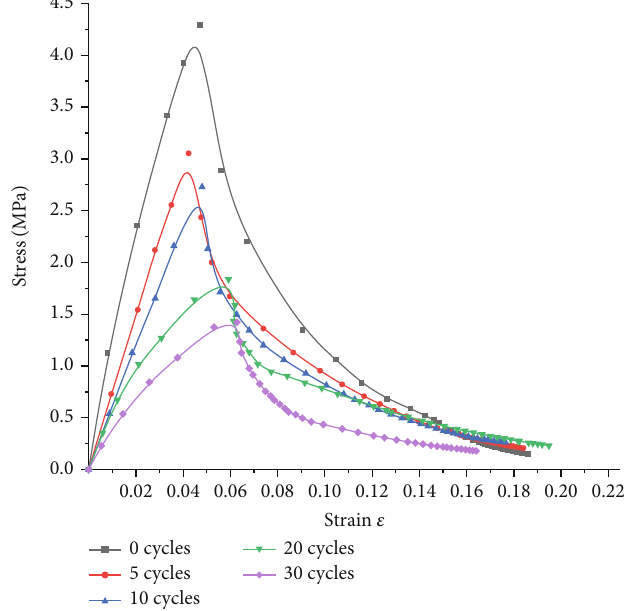
Figure 9: Sandstone stress-strain curves.